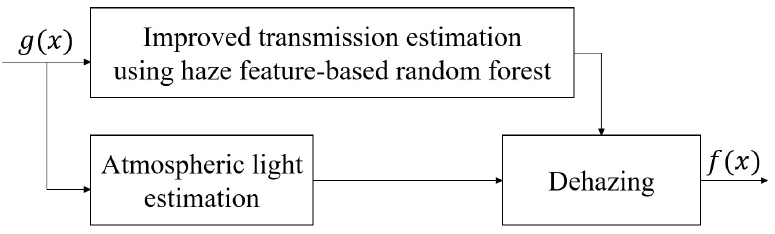
Figure 1. The block diagram of the proposed